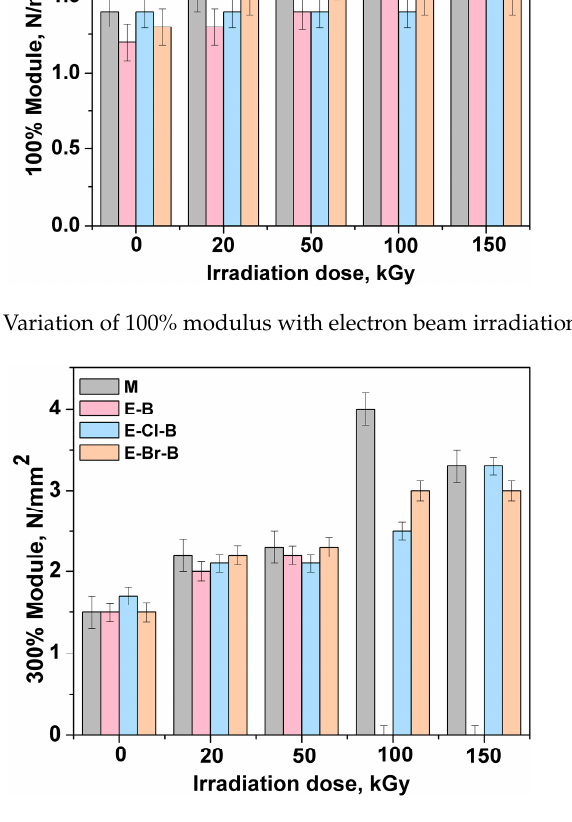
Figure 5. Tensile strength of EPDM/butyl rubber composites as a function of irradiation dose.